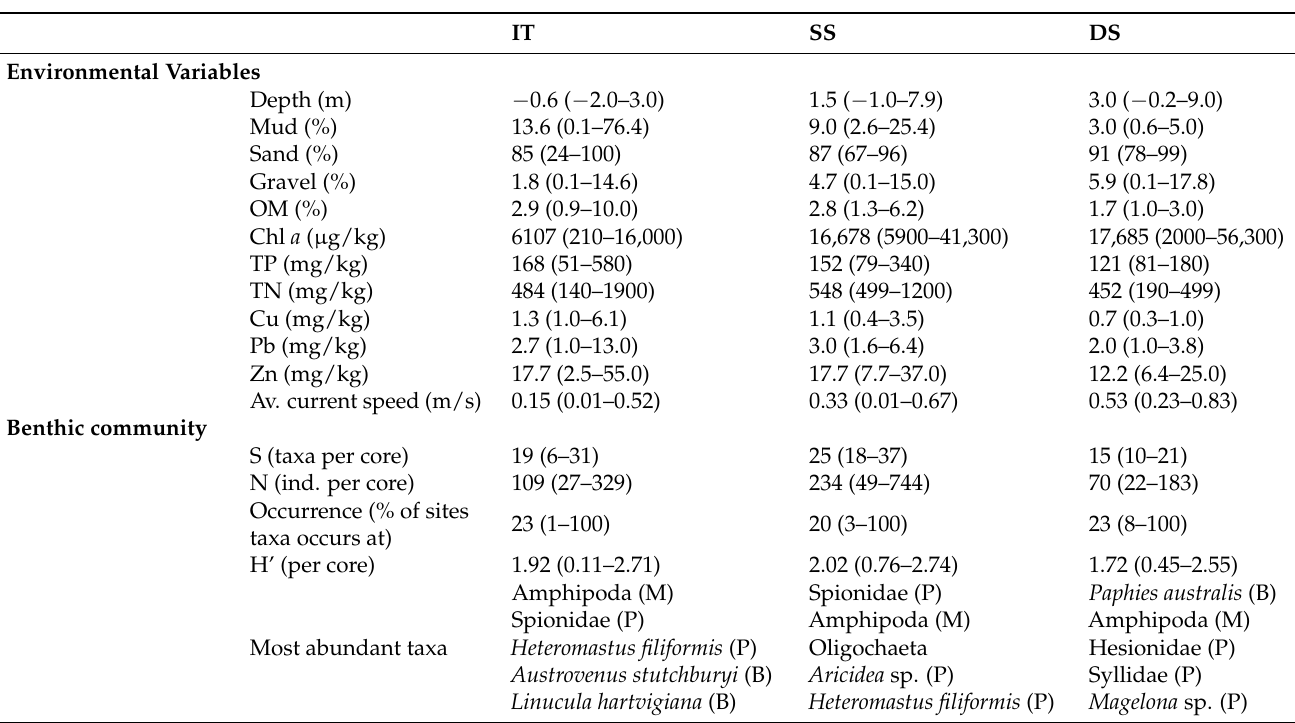
Table 2. Summary of average environmental and univariate macrofauna diversity measures (min- max) measured in Tauranga Harbor as a function of tidal zones; intertidal (IT, n = 70), shallow subtidal (SS, n = 36) and deep subtidal (DS, n = 13).